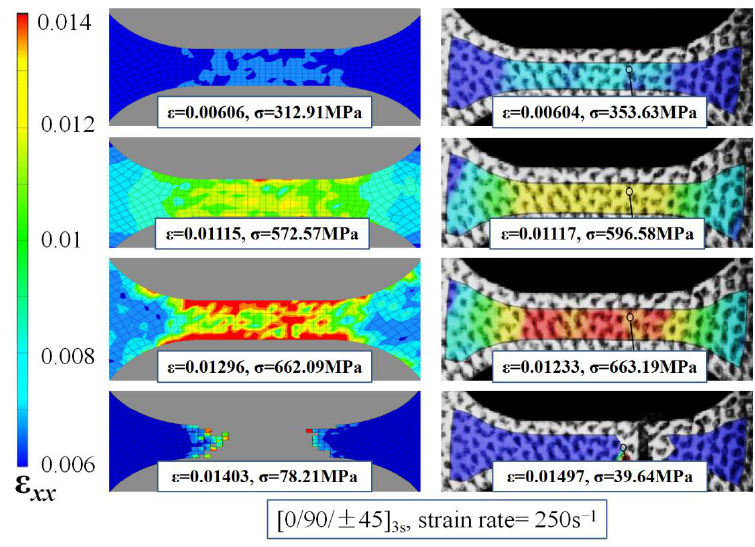
Figure 5. Simulated and DIC strain distributions.